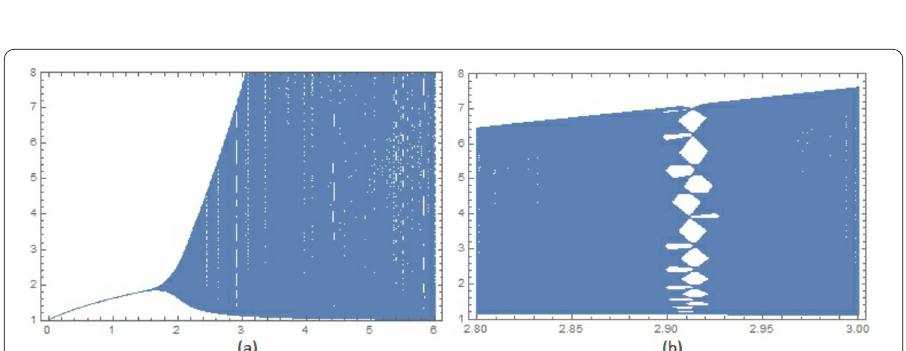
Figure 4 Bifurcation diagrams in the p – x